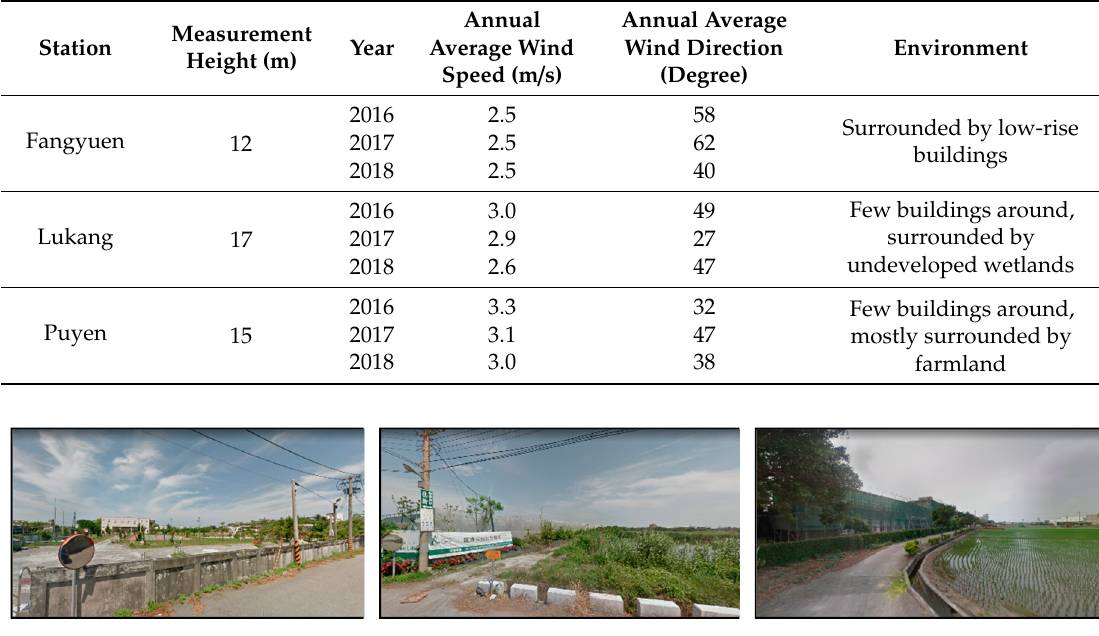
Figure 5. Environment of the CWB stations in Fangyuen ( left ), Lukang ( middle ), and Puyen ( right ).